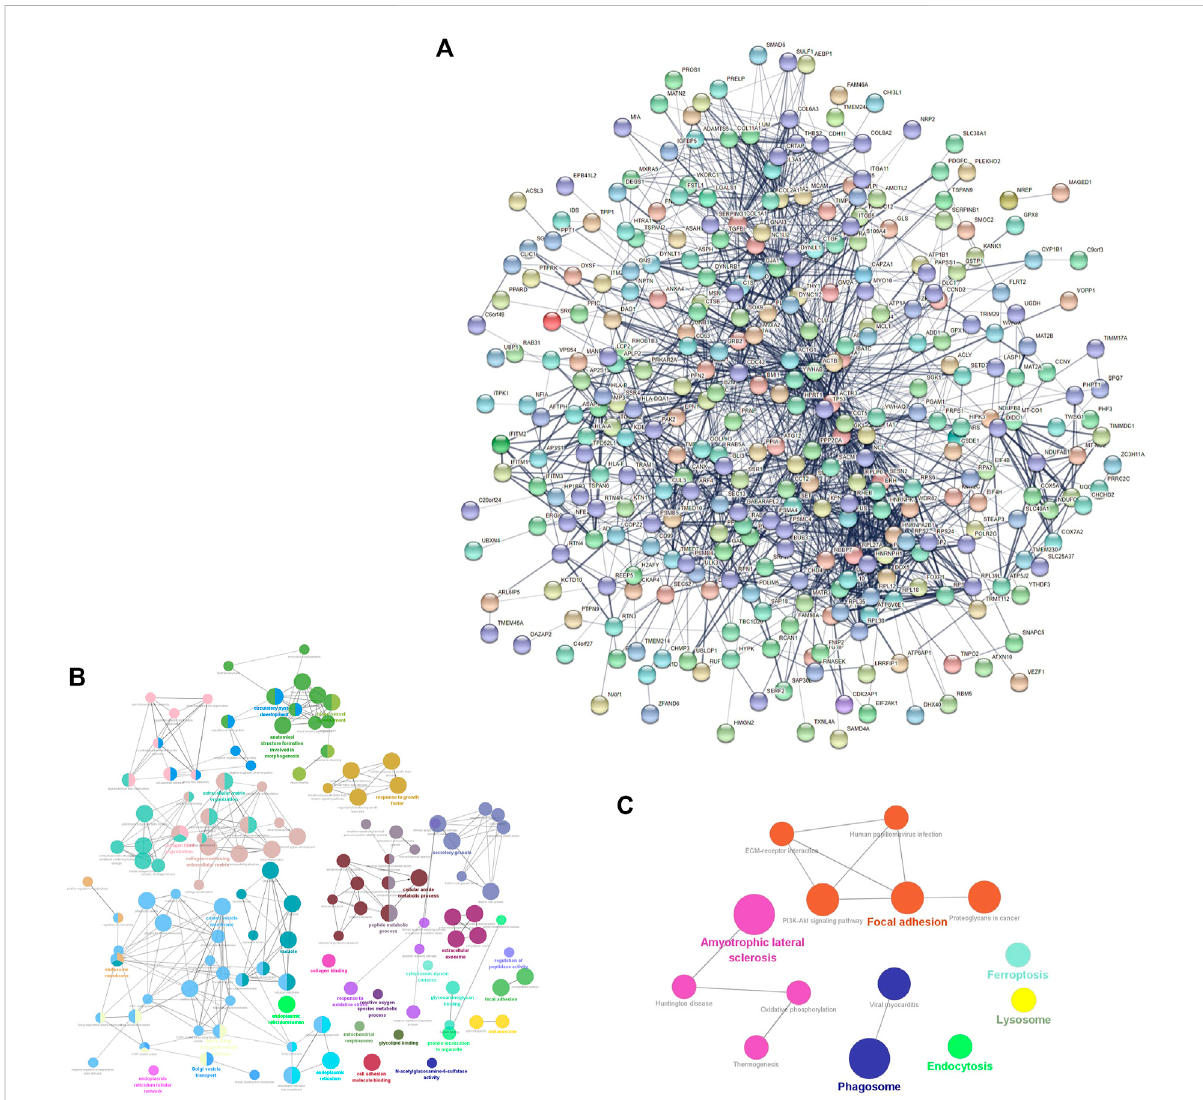
FIGURE 2 mRNA-related PPI networks in IDD. (A) PPI network of differentially expressed mRNAs in IDD. (B) clueGO-GO analysis of genes in PPIs that had differentially expressed mRNAs associated with IDD. (C) clueGO-KEGG analysis of genes in PPIs that had differentially expressed mRNAs associated with